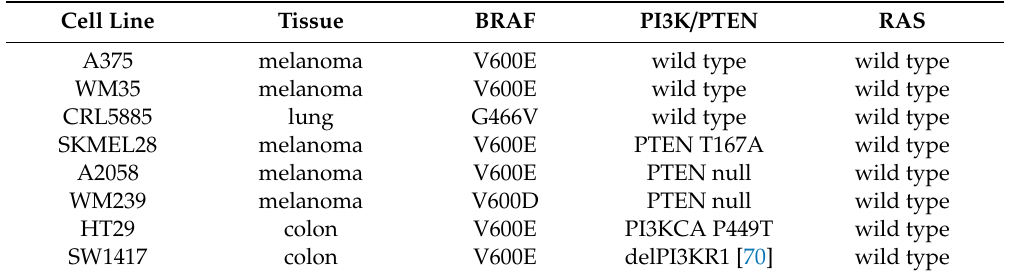
Table 1. Mutational status of the cell lines (based on CCLE, COSMIC, and ExPASy databases). Cell Line Tissue BRAF PI3K / PTEN RAS A375